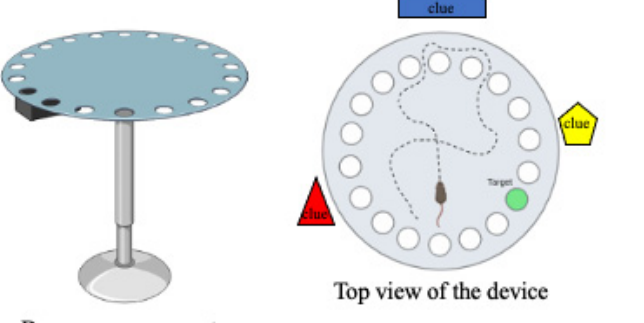
Figure 8. The Barnes maze test in mice. Different cues are given to the mouse to find an escape in the Barnes maze apparatus. Created with Biorender.com.